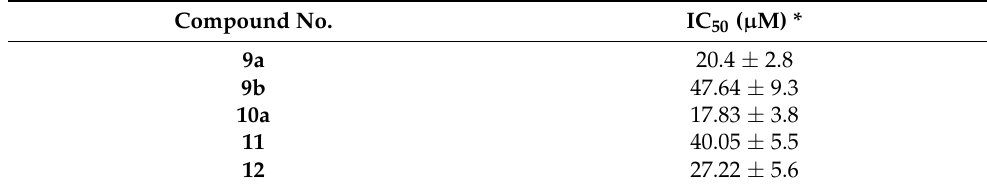
Table 4. IC 50 values in µ M reflecting FLT3 kinase inhibitory activity of the selected compounds. Compound